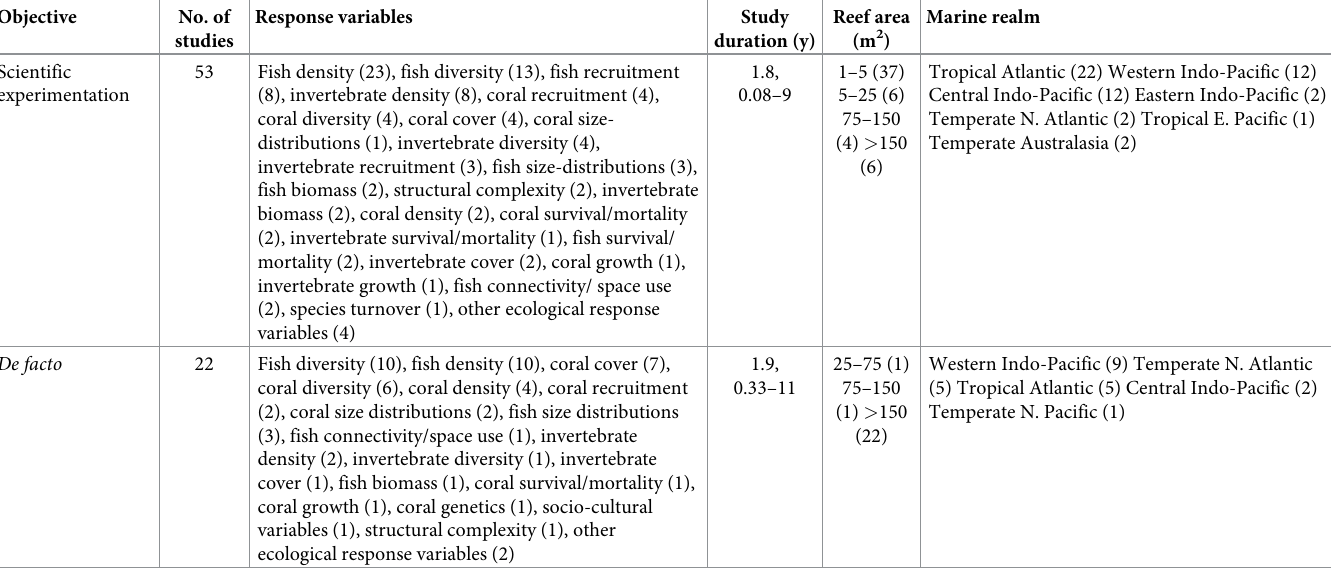
Table 1. AR deployment for scientific experimentation or de facto ARs deposited as marine waste or accidental submergences (n = 75 studies).